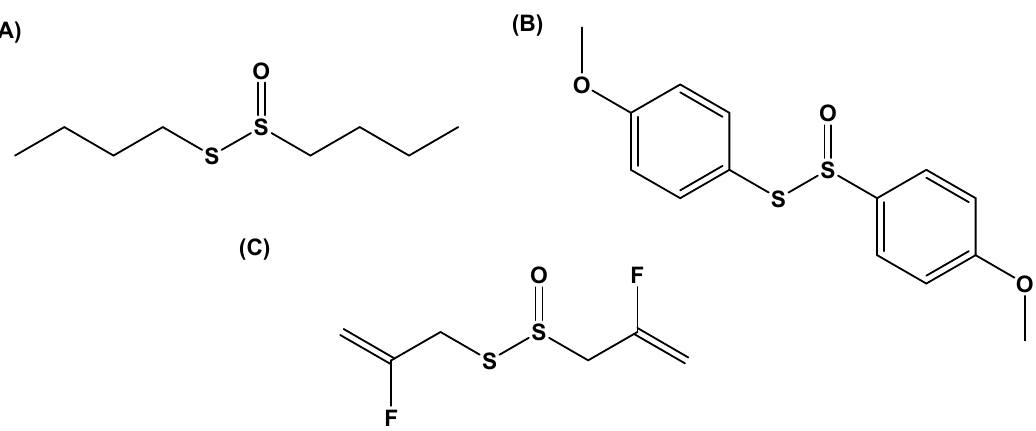
Figure 3. Structures of novel synthetic sulfur compounds based on the naturally occurring thiosulfinate allicin. Several thiosulfinate derivatives have anticancer properties, like ( A ) S -butyl butane-1-sulfinothioate, ( B ) S -4-methoxyphenyl 4-methoxybenzenesulfinothioate [60], and ( C ) novel antithrombotic agent difluoroallicin [61].